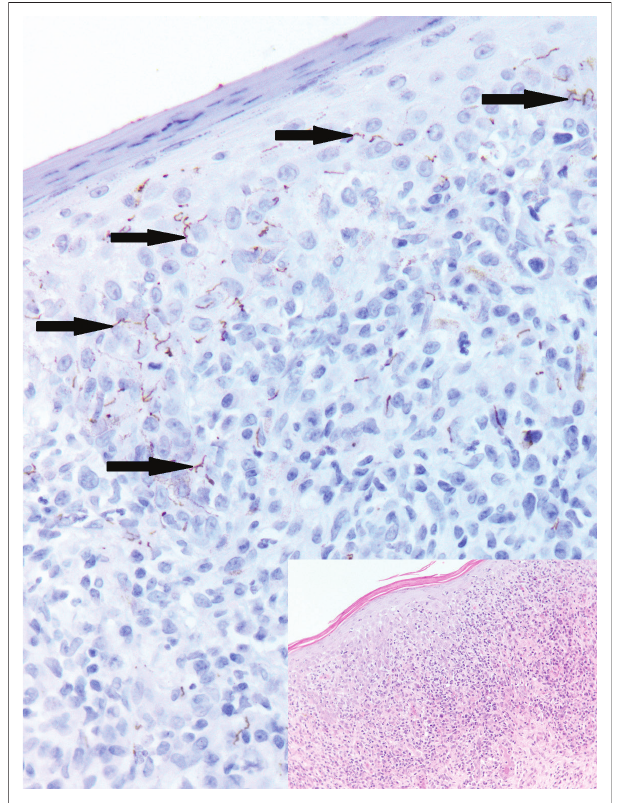
FIGURE 5: Numerous spirochaetes are identified on T. pallidum immunohistochemistry performed on the skin biopsy (original magnification × 400). A lichenoid lymphoplasmacytic infiltrate is noted on haematoxylin and eosin (inset) (original magnification × 200).